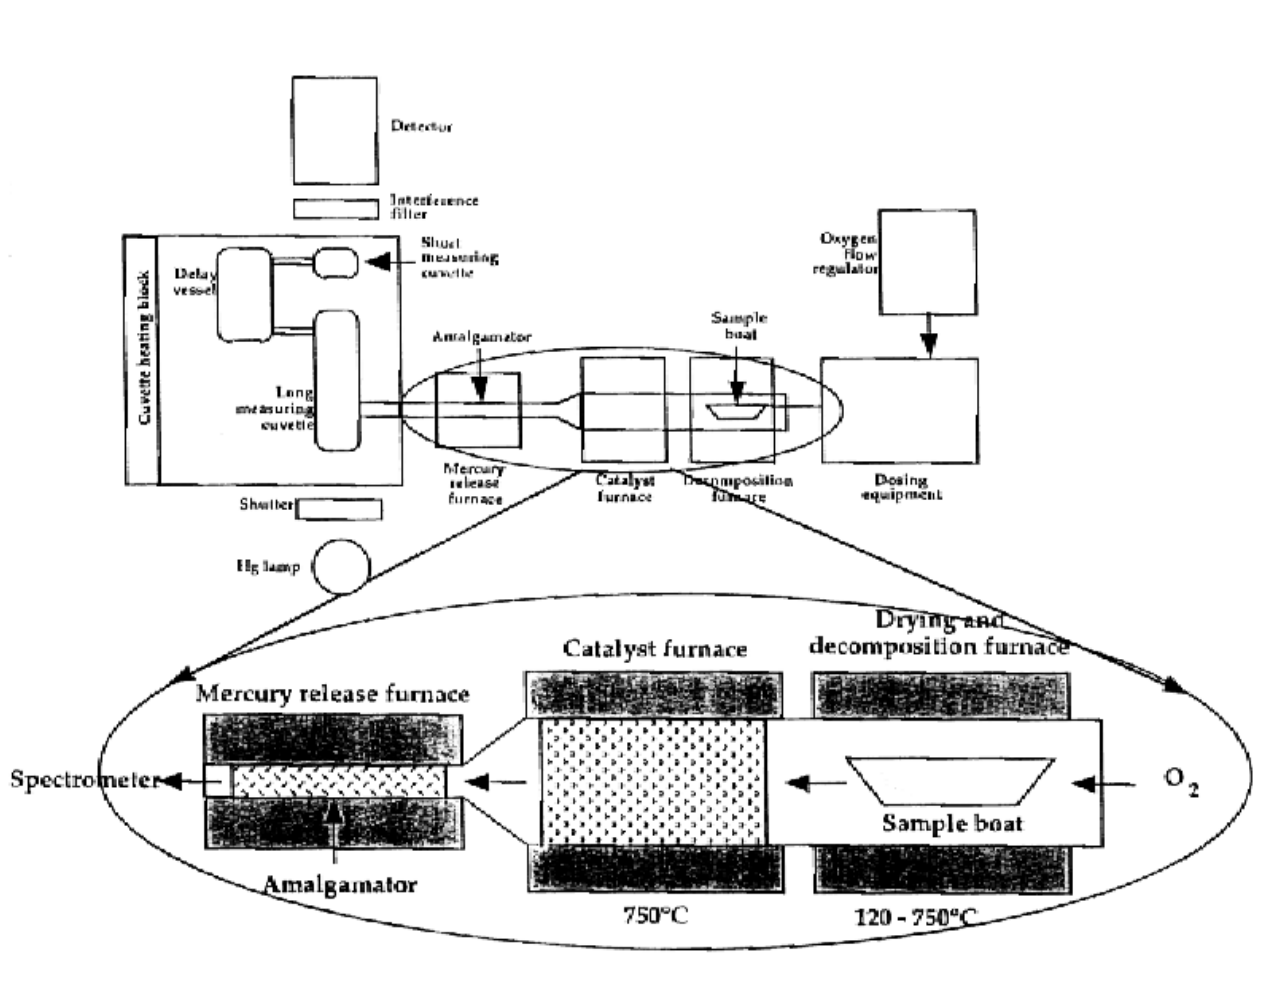
DIAGRAM OF THE MERCURY ANALYSIS